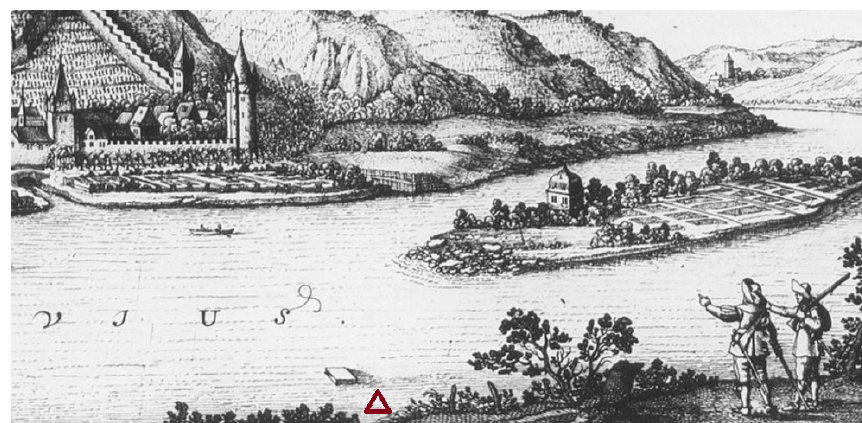
Figure 2. Drawing documenting the position of the hunger stone known as Ara Bakchi, Altarstein and Elfenstein near Bacharach, perhaps in the dry season of 1636, 1639 or 1642 (Merian, 1645), the position of which is marked by a red triangle in a cut-out view of Bacharach.